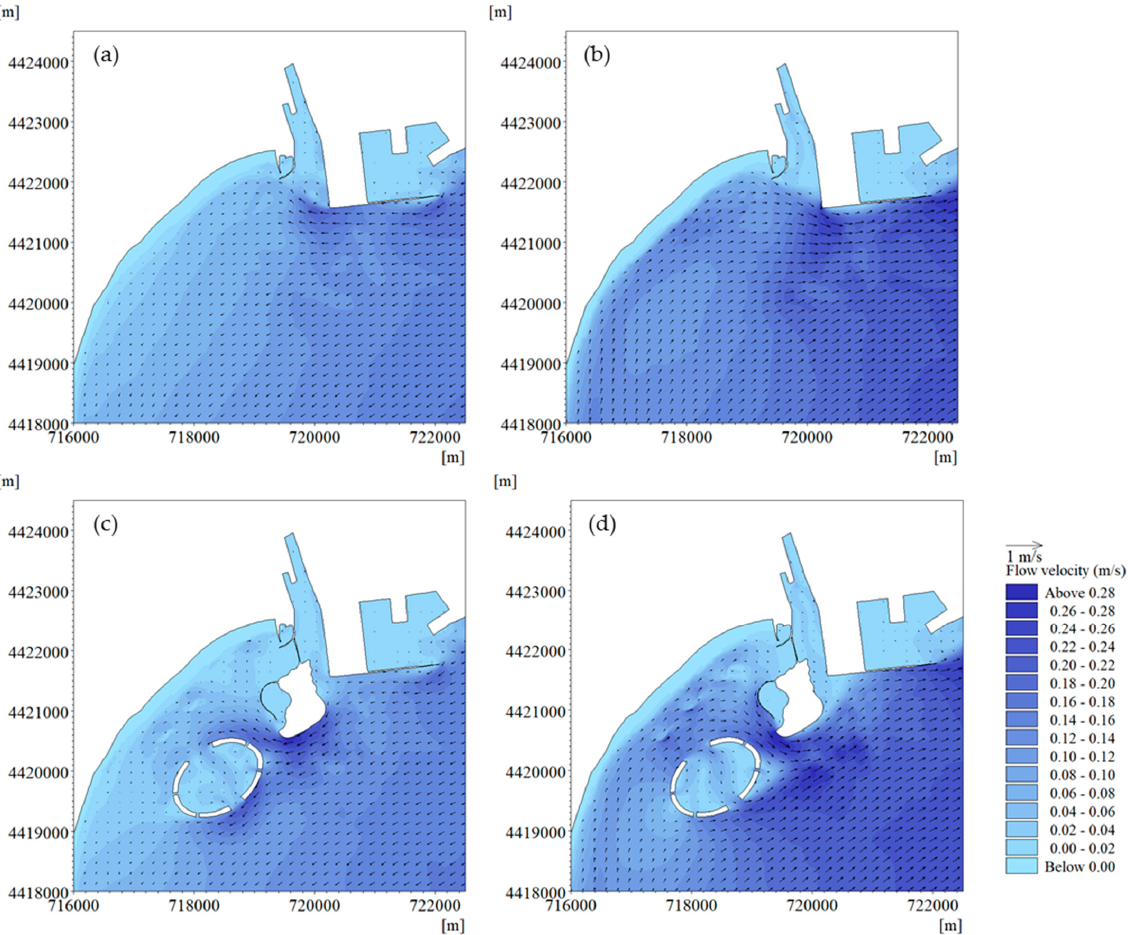
Figure 11. Flow fields at ( a ) the peak flood, ( b ) the peak ebb during a typical spring tidal period under the initial construction conditions and ( c ) the peak flood, ( d ) the peak ebb during a typical spring tidal period, under the first-stage construction conditions. spring tidal period, under the first-stage construction